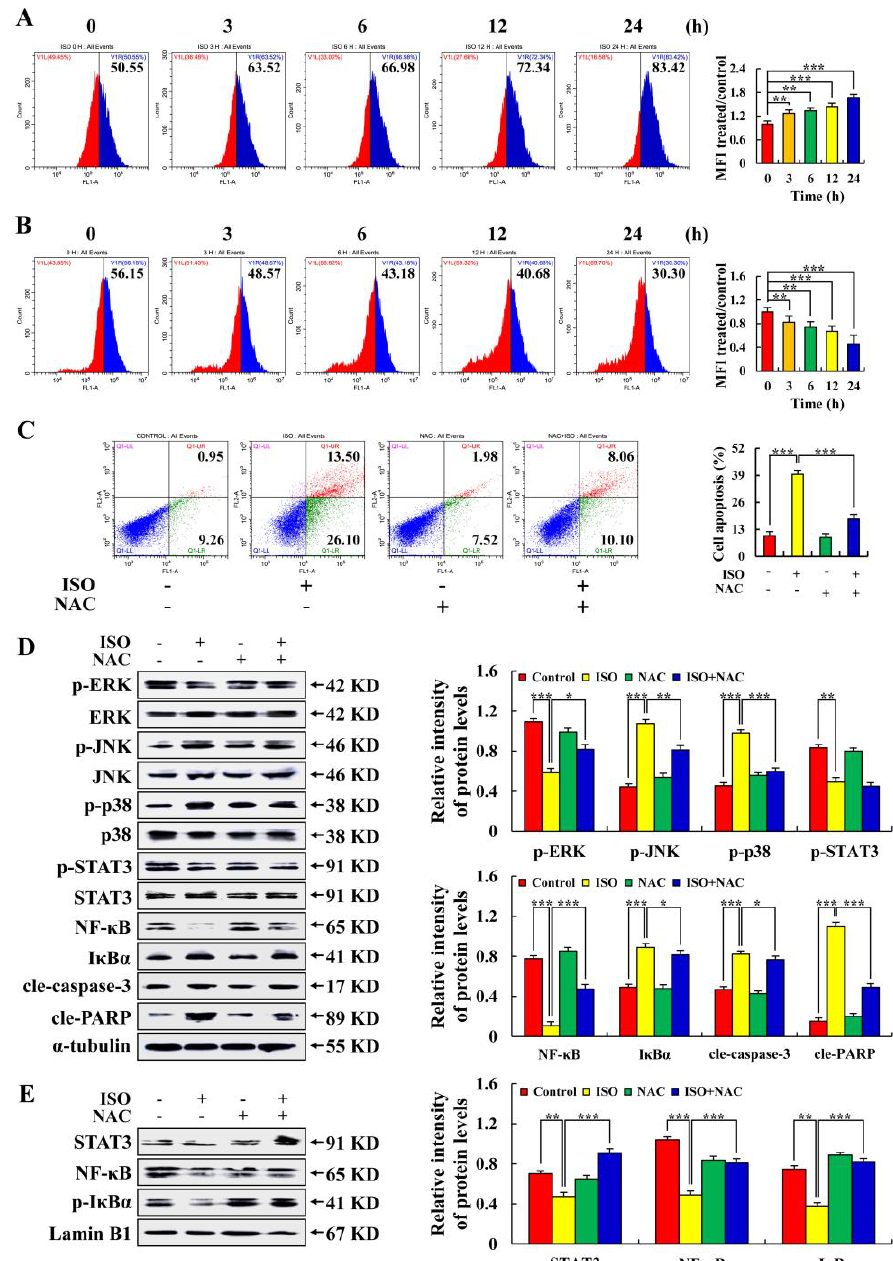
Figure 4. The promoting effects of ISO on ROS levels in AGS cells. A total of 36.54 µM ISO was applied to cells from 0 to 24 h. ( A ) AGS cell levels of ROS. ( B ) GES–1 cell levels of ROS. ( C ) Apoptosis rate of AGS cells treated with ISO (36.54 µ M) and/or NAC (10 mM). ( D ) Expression levels of related signaling pathway proteins in AGS cells treated with ISO (36.54 µ M) and/or NAC (10 mM). ( E ) Expression levels of nuclear proteins in AGS cells treated with ISO (36.54 µ M) and/or NAC (10 mM). Lamin B1 and α –tubulin were used as an internal reference protein. * p < 0.05, ** p < 0.01 and *** p < 0.001 vs. 0 h or NAC +